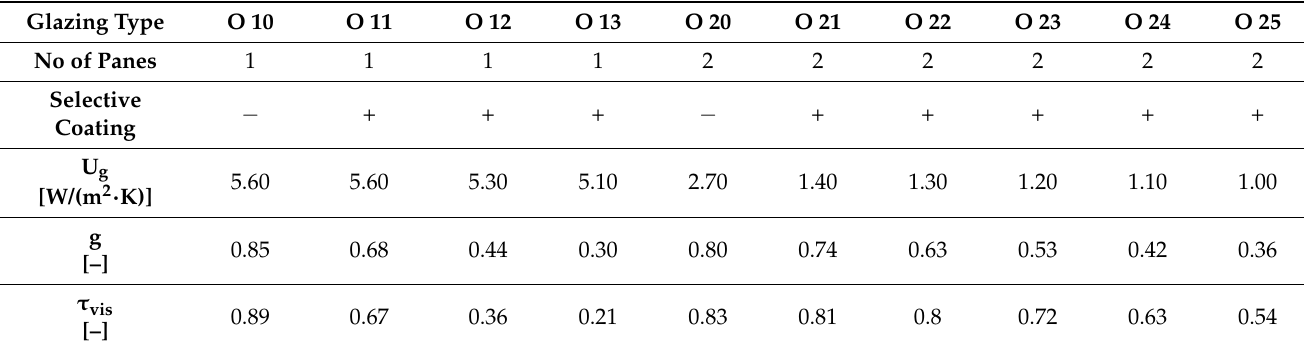
Figure 2. Glazing height and layout. Table 1. Configuration of glazing and balcony enclosure